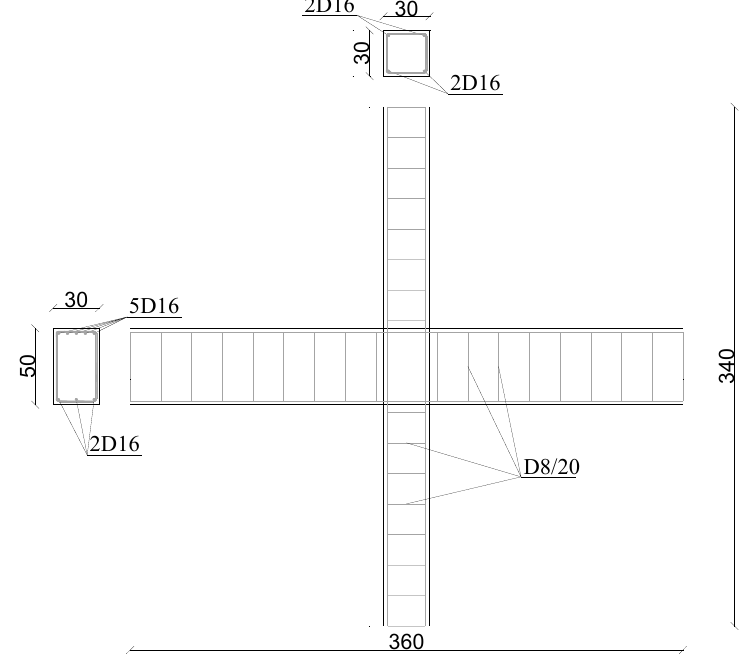
Figure 4. Geometry and reinforcement of analyzed beam column joint.